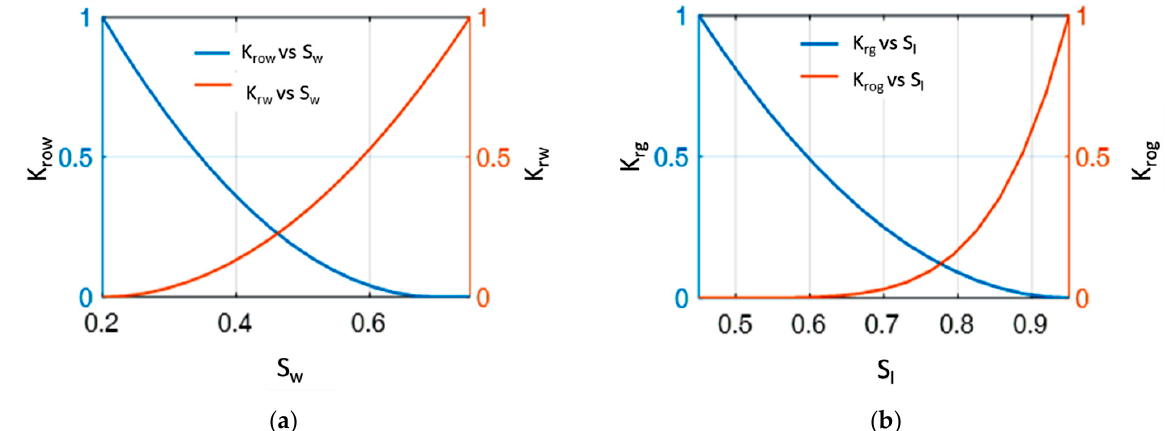
Figure 3. The end-point relative permeability for ( a ) K r vs. S w ; ( b ) K r vs. S l [25].